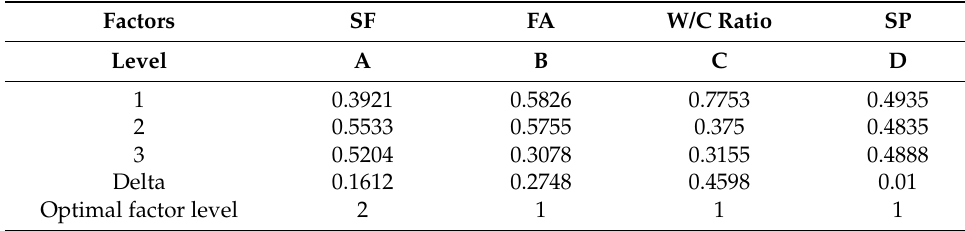
Figure 9. Graphs of parameter effects using FTOPSIS. Table 6. Optimum factor levels using TOPSIS.